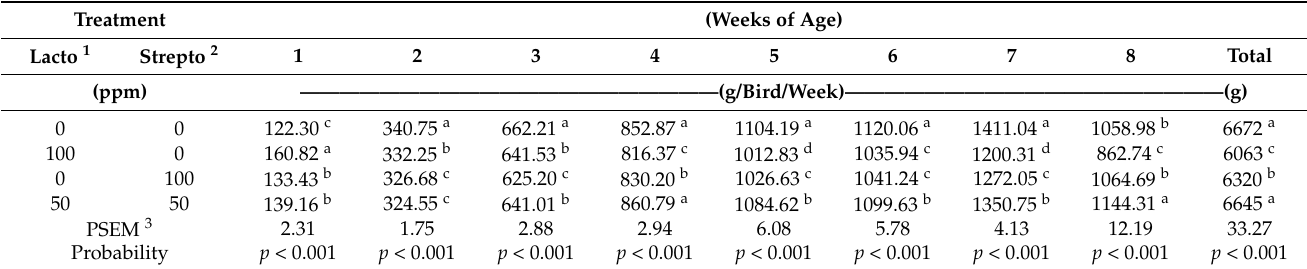
Table 2. Feed consumption of broiler chickens fed diets containing probiotics from hatch to 8